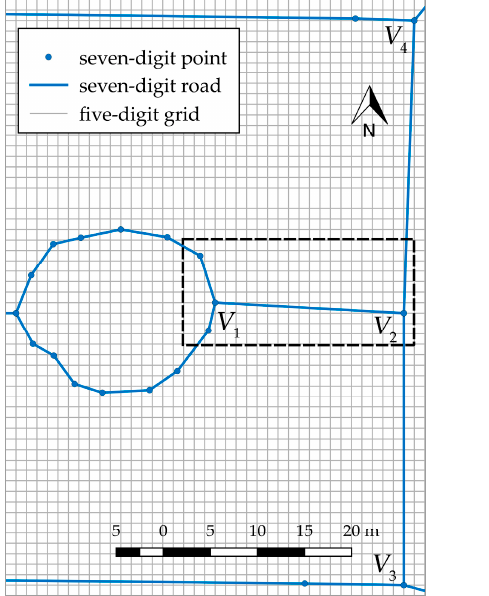
Figure 12. Connection situations of a general node: ( a ) two excluded connection situations; ( b ) optimal connection situation.